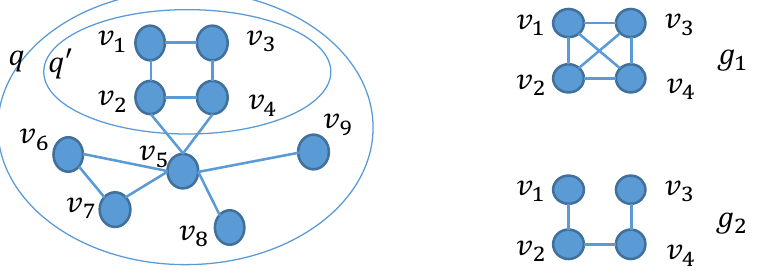
Figure 6. Inclusion of graphs and